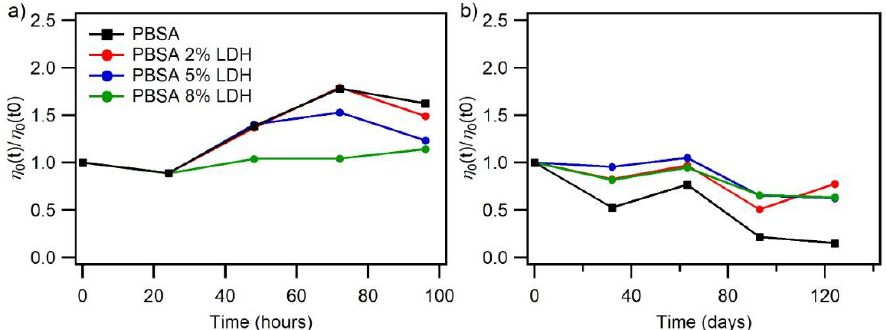
Figure 7. Differences in zero shear viscosity of PBSA and PBSA-LDH films as a function of exposure time in ( a ) the accelerated photoaging chamber (SEPAP 12–24) and ( b ) natural